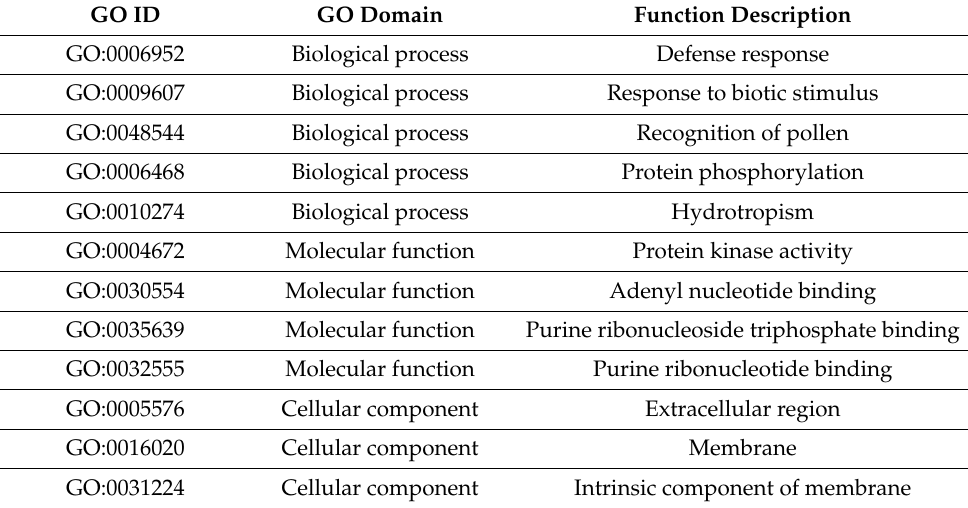
Table 3. The gene ontology (GO) term distribution of PnPR-1 proteins.